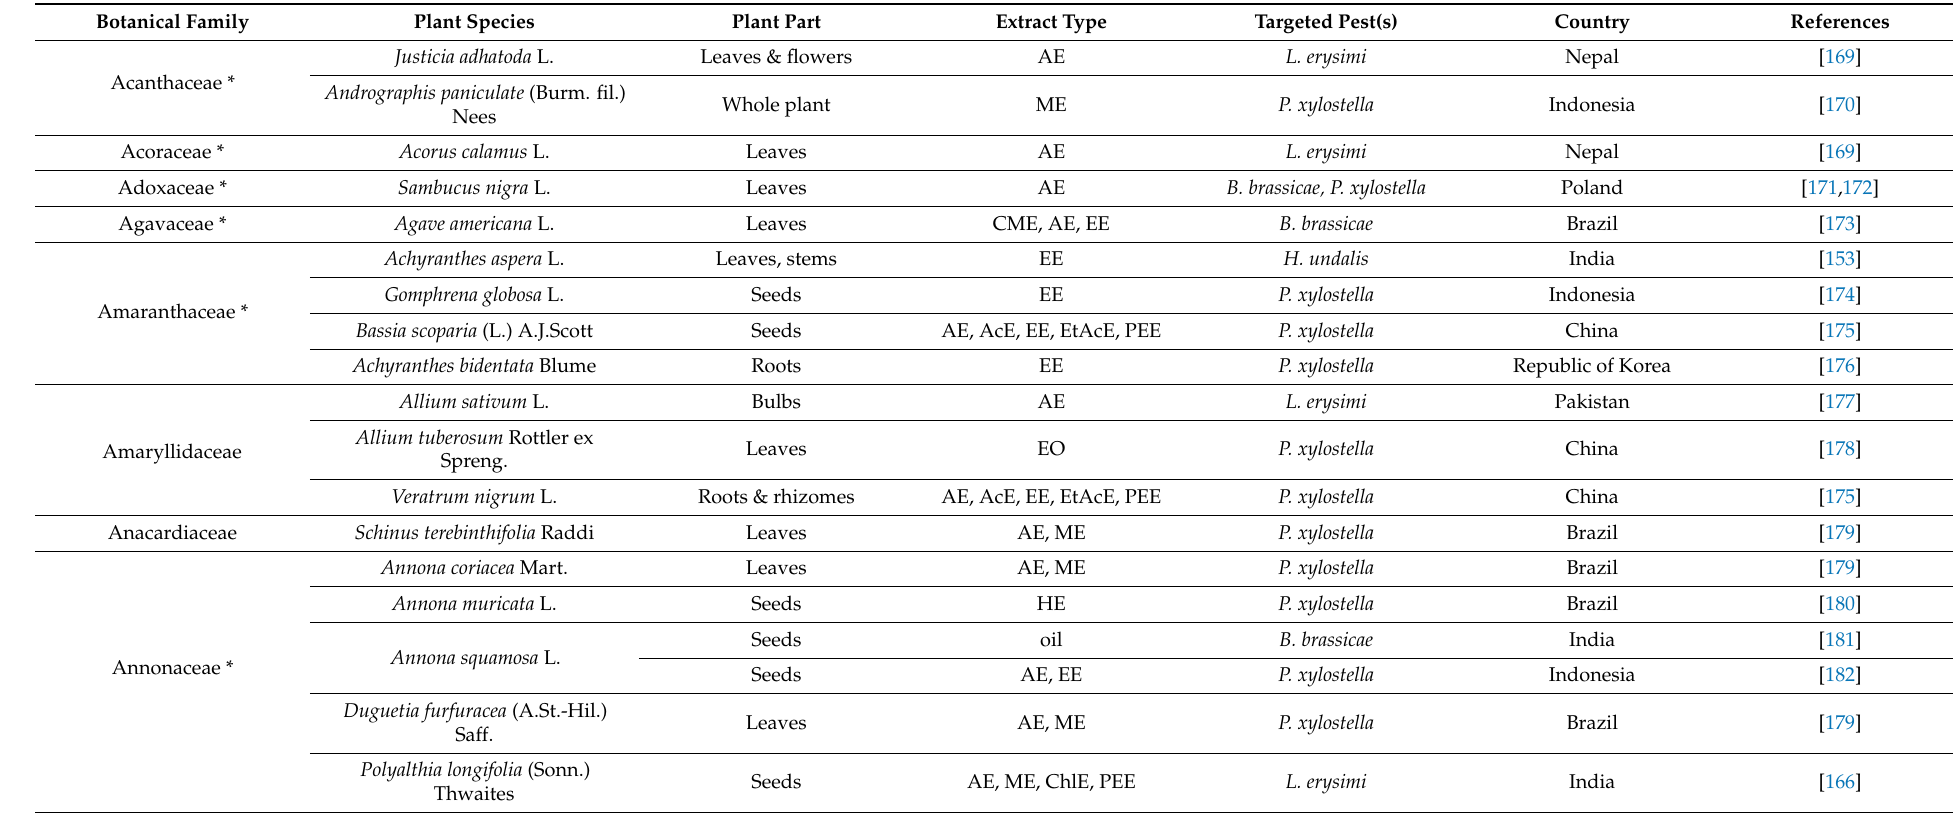
Table 5. Plant species tested or currently used for managing P. xylostella , H. undalis and aphids ( L. erysimi, B. brassicae or L. pseudobrassicae ) outside